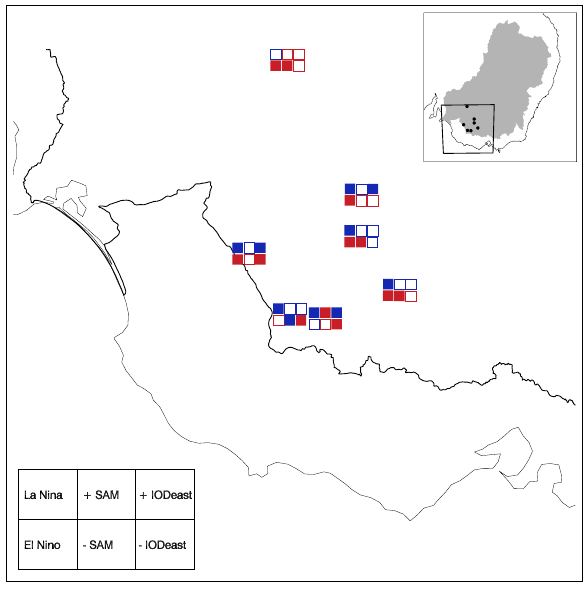
Fig. 5. The squares represent the difference in the 6-monthly (April–September) mean number of heavy rain days (defined as days with over 25mm of rainfall) between years experiencing neu- tral and extreme phases of ENSO, SAM and Indian Ocean SST vari- ations. The mean number of rain days during years in the positive (top row) and negative (bottom row) phases of ENSO (left column), SAM (centre column) and eastern Indian Ocean SSTs (right col- umn) are shown. Blue indicates that a station has more, and red in- dicates that a station has less heavy rain days than in neutral years. A solid square indicates this difference is significant at the 95% level based on a confidence interval generated from 1000 bootstrap replicates of neutral